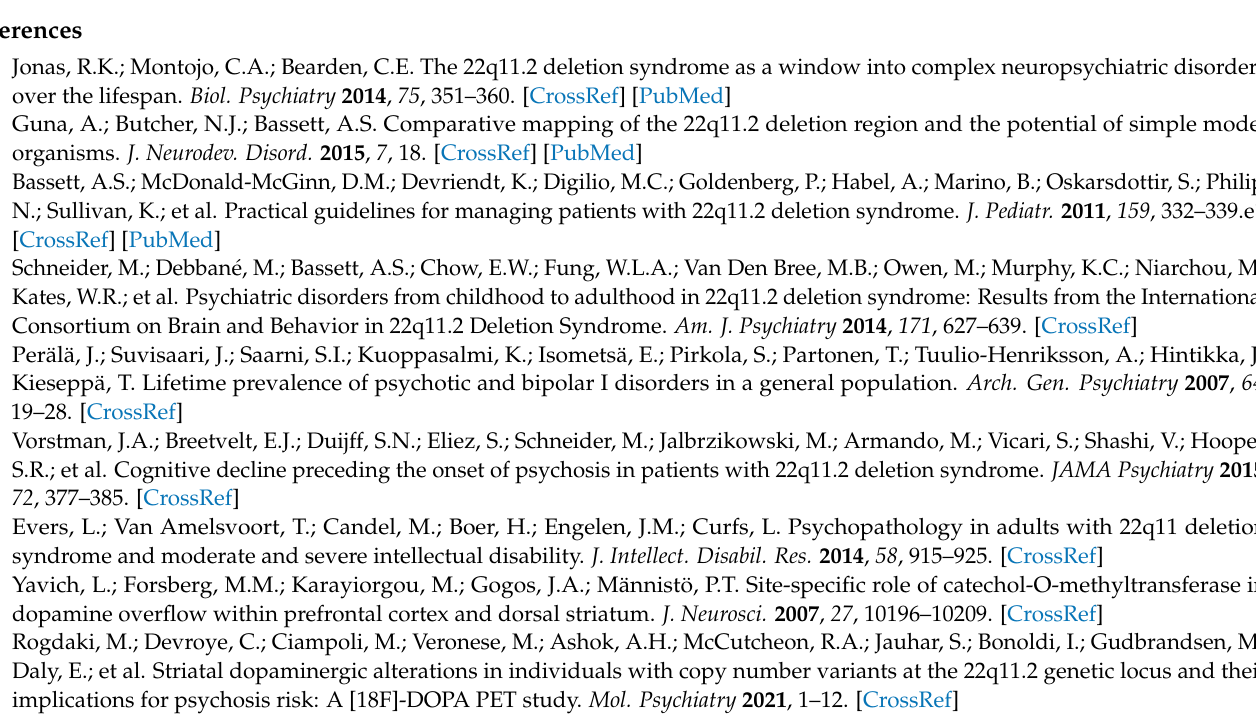
Table S3: Association between cognitive functioning and dopamine D 2/3 receptor availability in